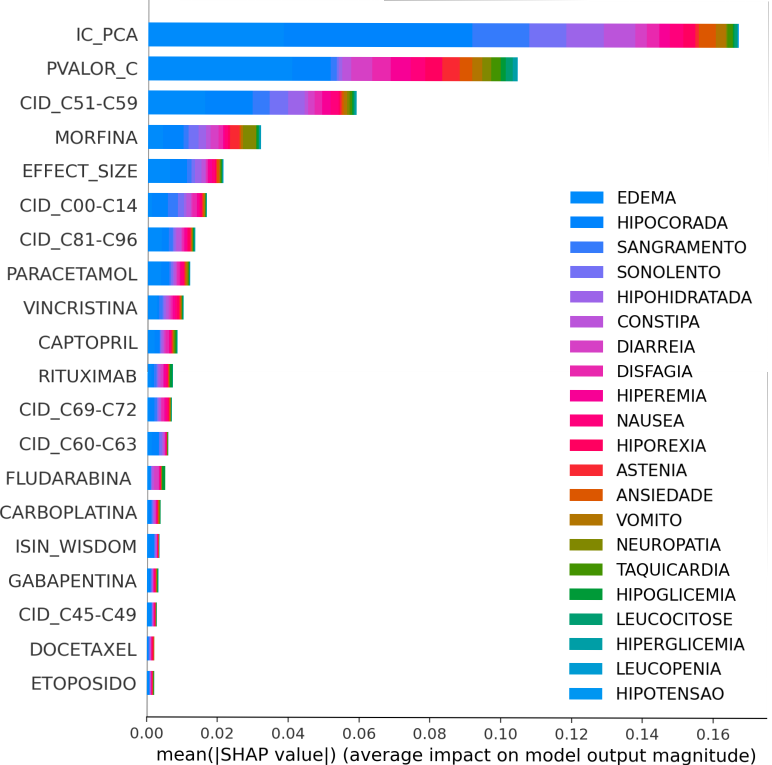
Figure 17. Shapley global impact for feature.